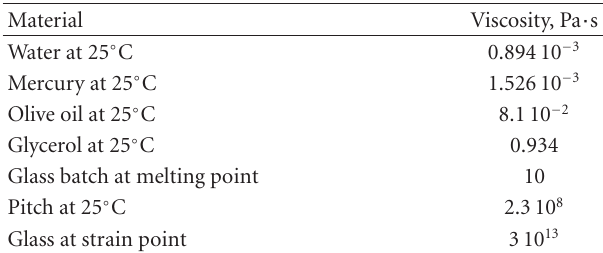
Table 2: Viscosity of some amorphous